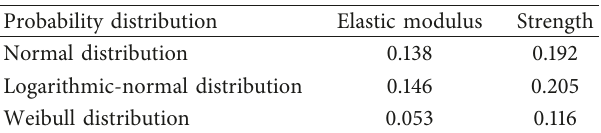
Table 1: Maximum differences between experimental and theo- retical distributions.